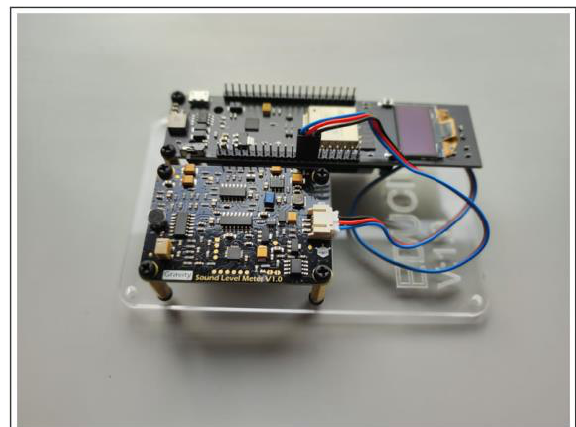
Figure 23. SmartSound kit.